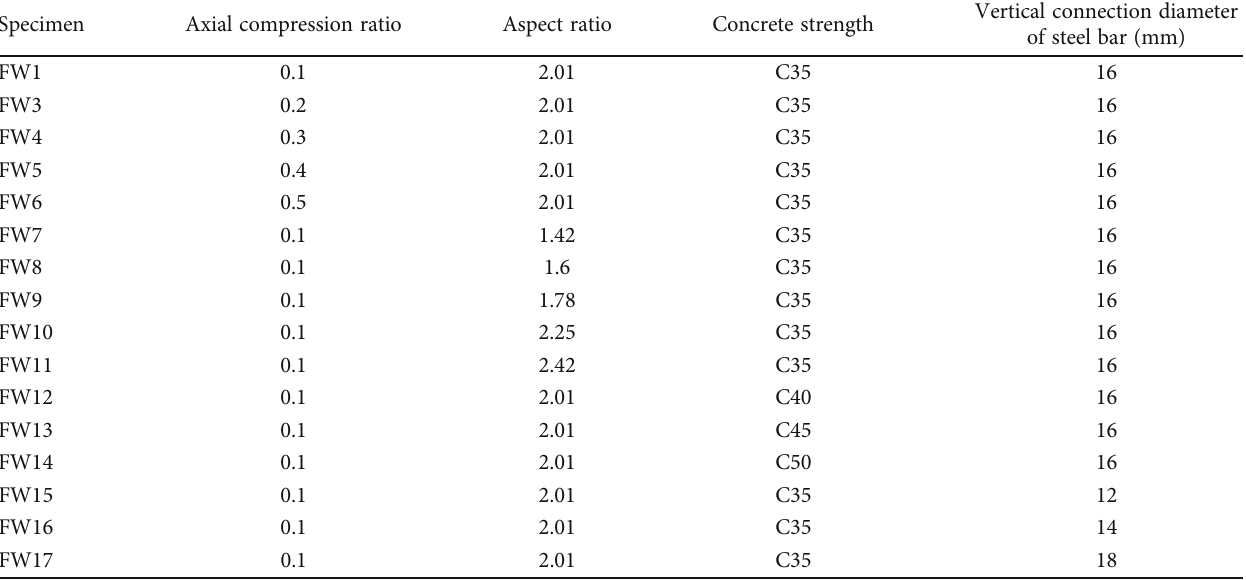
Table 4: Design parameters of each fi nite element